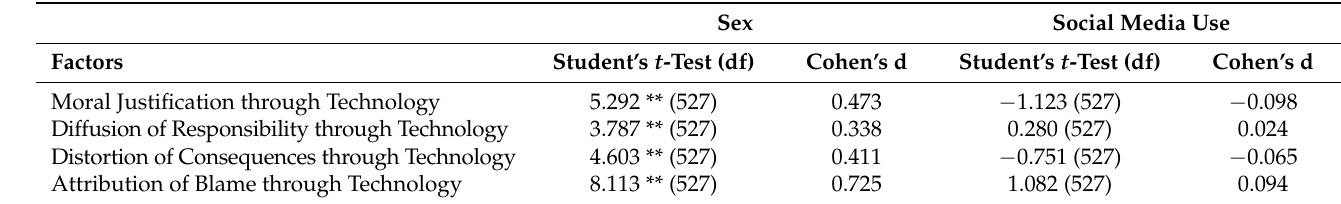
Table 3. Independent samples t -test.